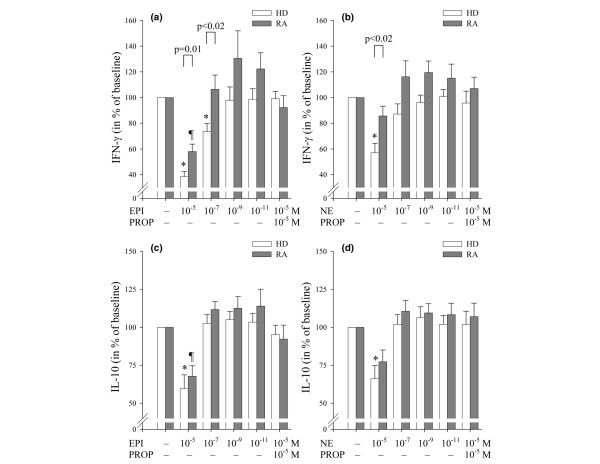
Modulation of interferon (IFN)-γ and interleukin (IL)-10 synthesis of activated T cells by catecholamines in healthy donors (HDs) (n = 16, white bars) and patients with rheumatoid arthritis (RA) (n = 16, gray bars). The concentrations of IFN-γ upon co-incubation with (a) epinephrine (EPI) and (b) norepinephrine (NE) and of IL-10 upon co-incubation with (c) EPI and (d) NE were determined in the culture supernatant by means of enzyme-linked immunosorbent assay after T-cell stimulation for 48 hours. The baseline values of each RA patient and HD were defined as 100%, and the cytokine concentrations upon co-incubation with catecholamines were expressed as percentage of baseline values. *p < 0.001 and ¶p < 0.05 denote significant differences in cytokine production of patients with RA or HDs compared with the control values. P values indicate significant differences between the catecholamine effects of patients with RA and HDs, respectively. PROP, propranolol.